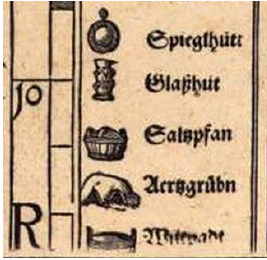
Fig. 1. A part of the legend concerning raw materials, their extraction and processing on sheet no. 13 of the map by Ph. Apian, 1568 (the collection